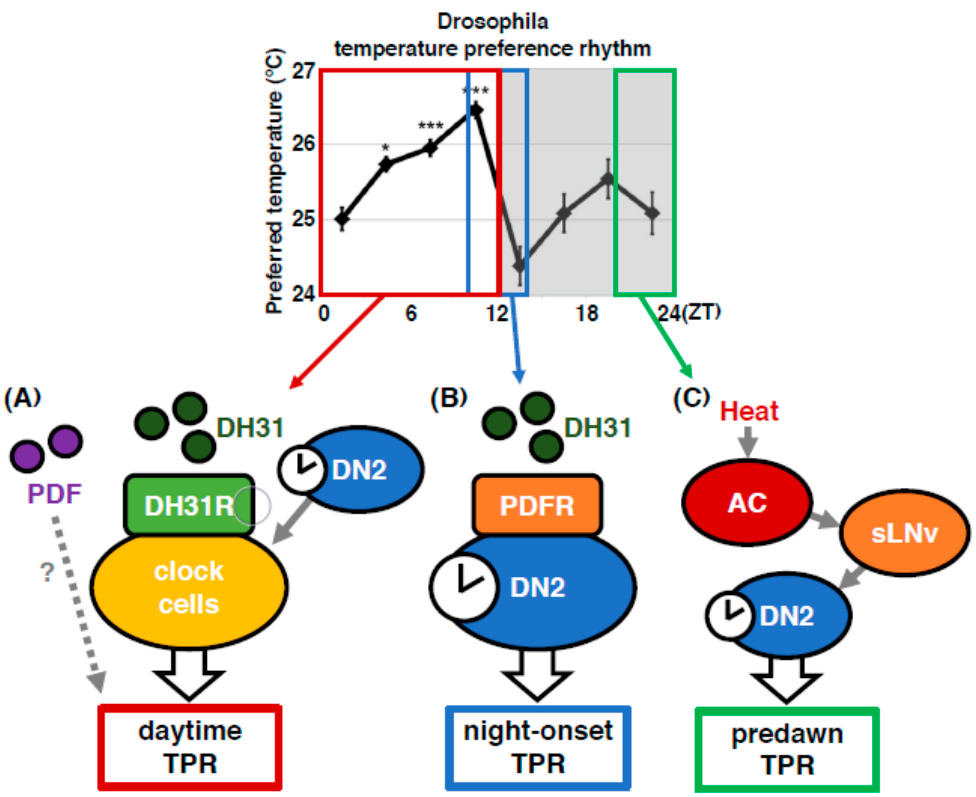
Figure 7. The Drosophila TPR is regulated by di ff erent mechanisms at di ff erent times of the day. Models for regulatory mechanisms of the TPR in each time range: daytime (ZT 1–12), night onset (ZT 10–15), and predawn (ZT 22–24). The daytime TPR: DN2s are the main clock neurons. DH31 acts on DH31R in a subset of clock neurons to regulate the daytime TPR. PDF is also involved in daytime TPR regulation. The night-onset TPR: DH31 acts on DN2s via PDFR to regulate the night-onset TPR. The predawn TPR: An AC-sLN-DN2 neural circuit regulates the proper setting of temperature preference before